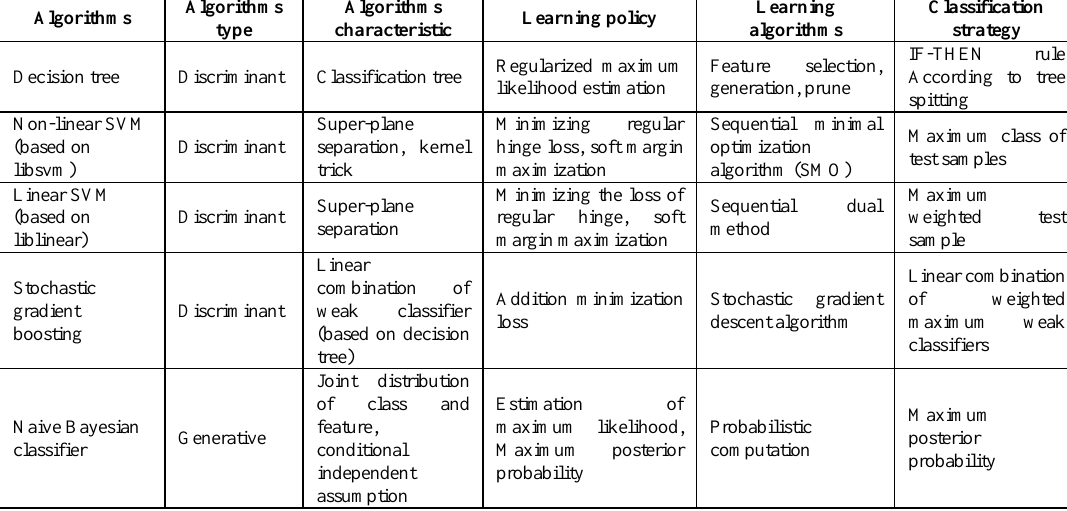
Table 1. Summary of several machine learning